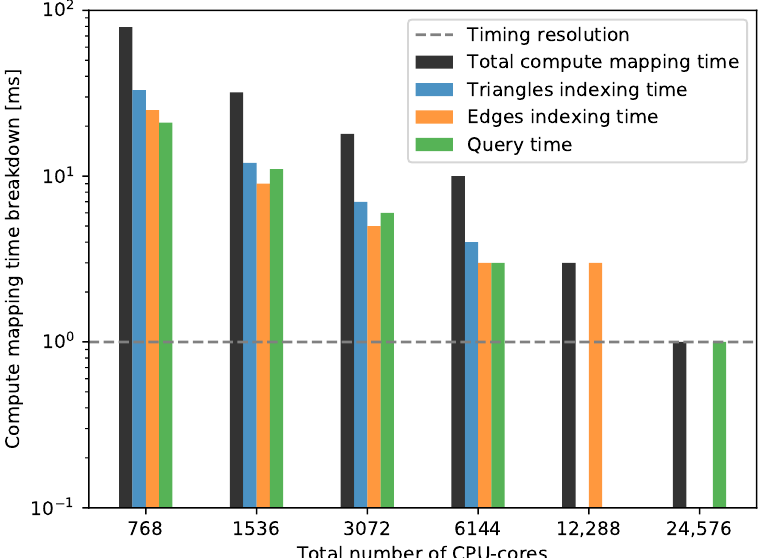
Figure 9. Strong scalability measurements: Breakdown of the mapping computation time of the two-level approach. The mesh M4 is used for conducting the analysis.